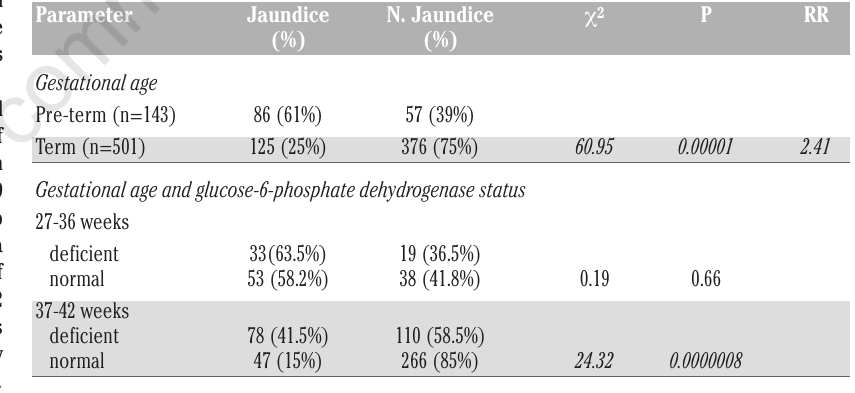
Table 2. Relationship between gestational age, glucose-6-phosphate dehydrogenase level and occurrence of